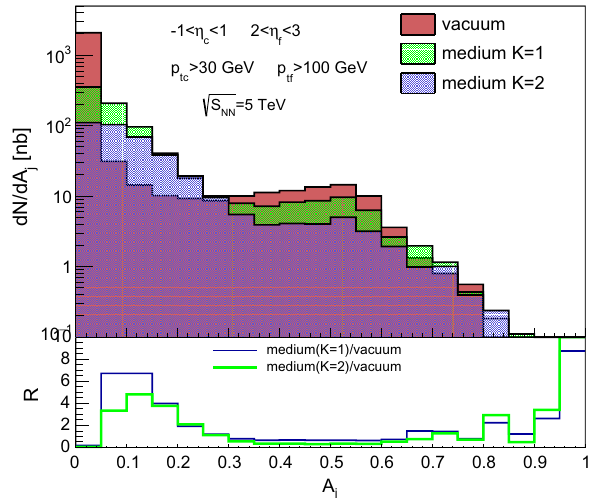
Fig. 4 a Top: Rapidity difference between the jets (cid:3)η before and after the jets pass through the medium. The red histogram represents the (cid:3)η of the jet before passing the medium. The light green histogram repre- sents the (cid:3)η spectrum of a jet quenched by the medium with transport coefficient K = 1; see (8). The blue histogram represents the (cid:3)η spec- trum of a jet quenched by the medium with transport coefficient K = 2. Bottom: Ratios of the histograms. b Top: Azimuthal angle between the